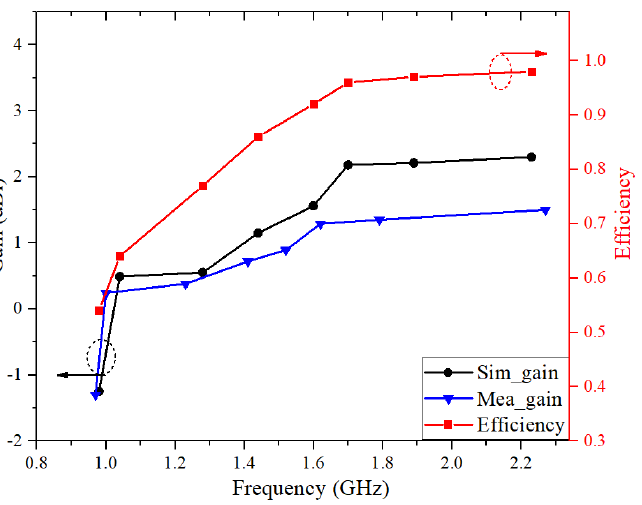
Figure 12. CST simulated and measured gain and efficiency at the resonant frequencies of different states.